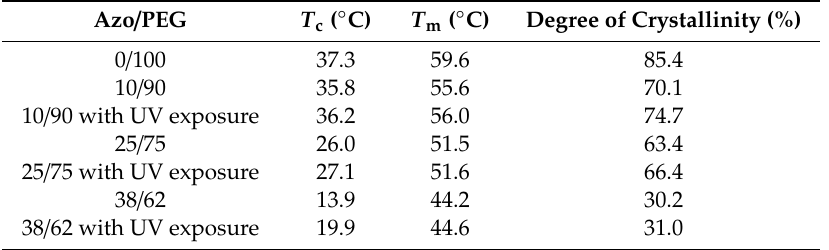
Table 2. Thermal and crystallization behaviors of Azo / PEG